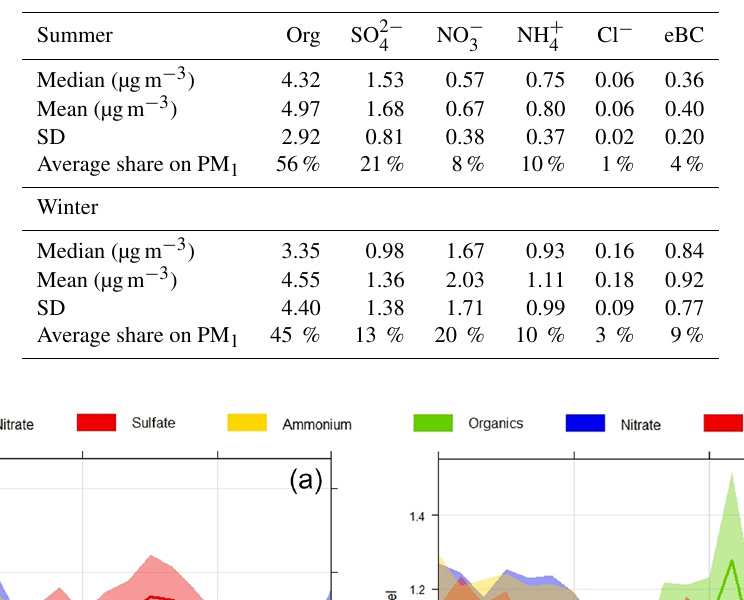
Table 2. Basic statistics of the NR-PM 1 and eBC concentrations (median, mean, standard deviation (SD), and average share of species in the total concentration) measured during summer and winter. The values were calculated from 5min resolution CE-corrected data.